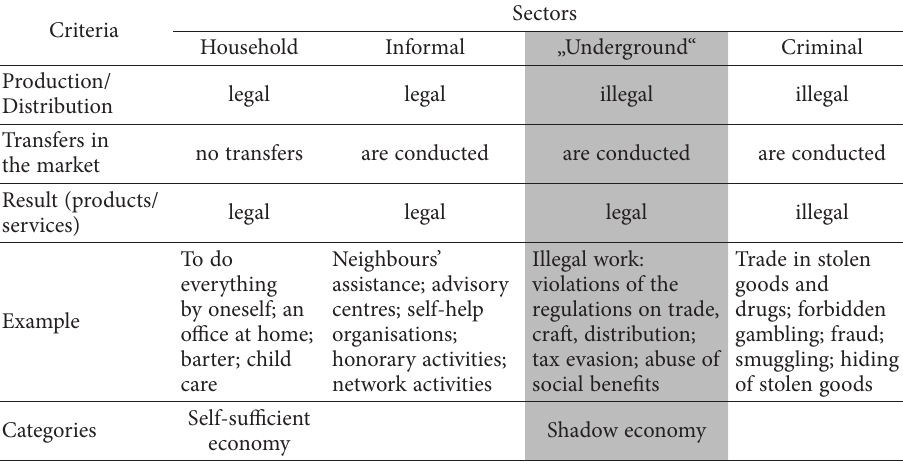
Table 1. Classification of shadow